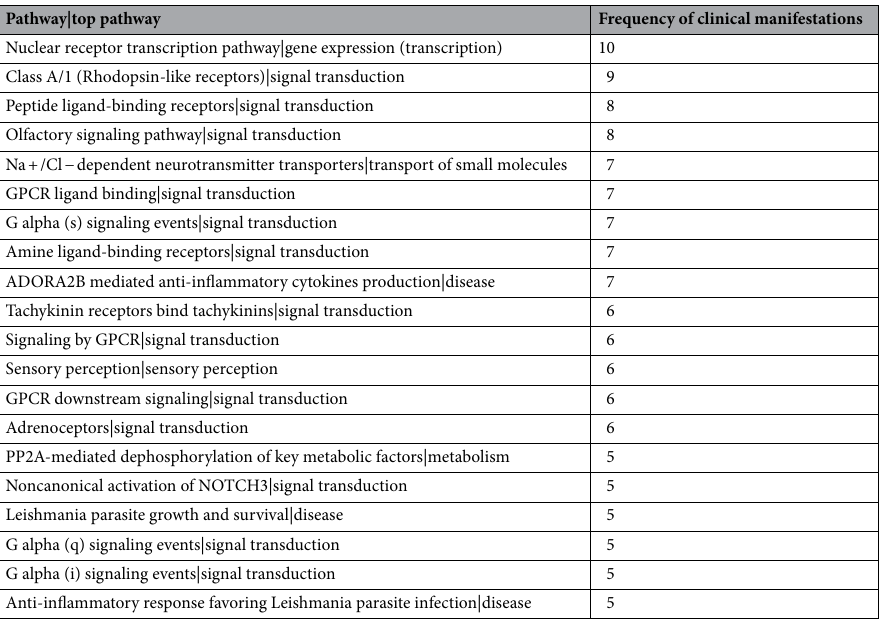
Table 4. Top 20 most frequent pathways across the GWAS clinical manifestations.